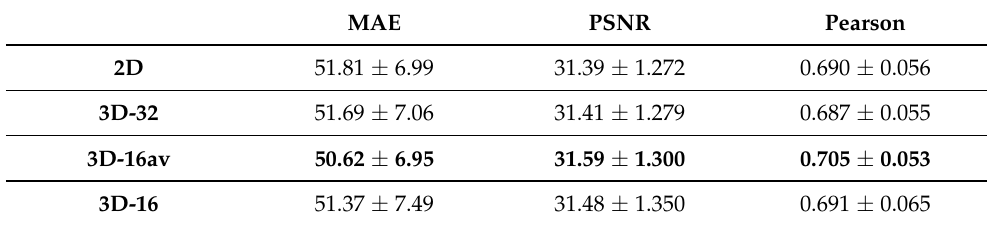
Table 17. Pelvis dataset with Atrous-net. Mean Absolute Error, PSNR and Pearson coefficient from Atrous-net using different convolutions and reconstructions in the Pelvis data set.